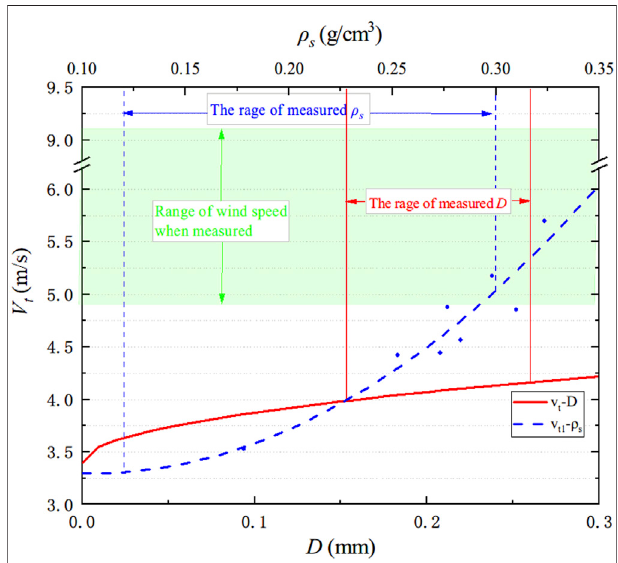
FIGURE 3 | Snow particle threshold wind velocity. In Figure 3 , the abscissa is the diameter of snow particles ( D ) and the accumulation density of snow particles ( ρ s ), and the ordinate is the starting wind speed ( V t ). The solid line is the relationship between D and V t , and the dashed line is the relationshipbetween ρ s and V t .Therangeof D and ρ s inthismeasurementwas marked, respectively. The green shaded area is the wind speed range when measured.Theresultsshowthatthesite ’ swindspeedmeetstherequirement of stable snow fl ow formation.